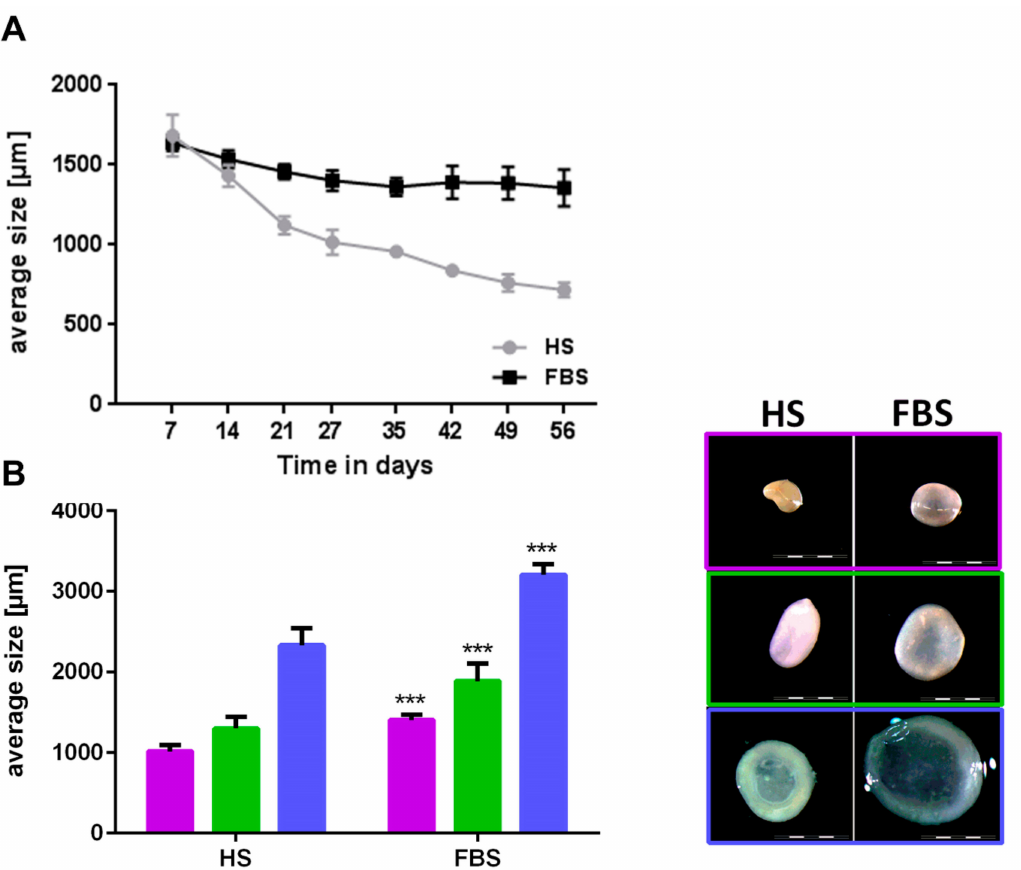
Figure 5. Comparison of size and macroscopic appearance of microtissues after cultivation in either HS or FBS. ( A ) Development of the size of microtissues from one representative donor over the course of 8 weeks. ( B , left) Mean sizes of 10 microtissues of three donors after 4 weeks of cultivation. Each color represents a di ff erent donor. ( B , right) Macroscopy of microtissues of the corresponding donors depicted in the graph. Scale bars: 2000 µ m. Data are depicted as mean ±